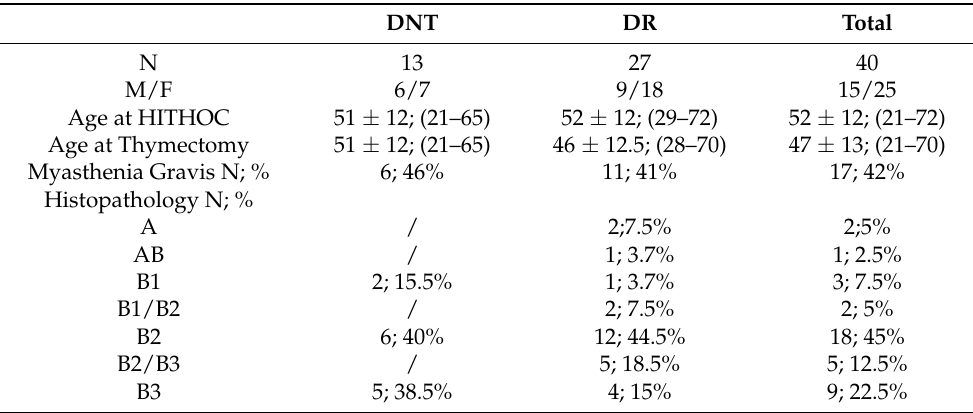
Table 1. Population main